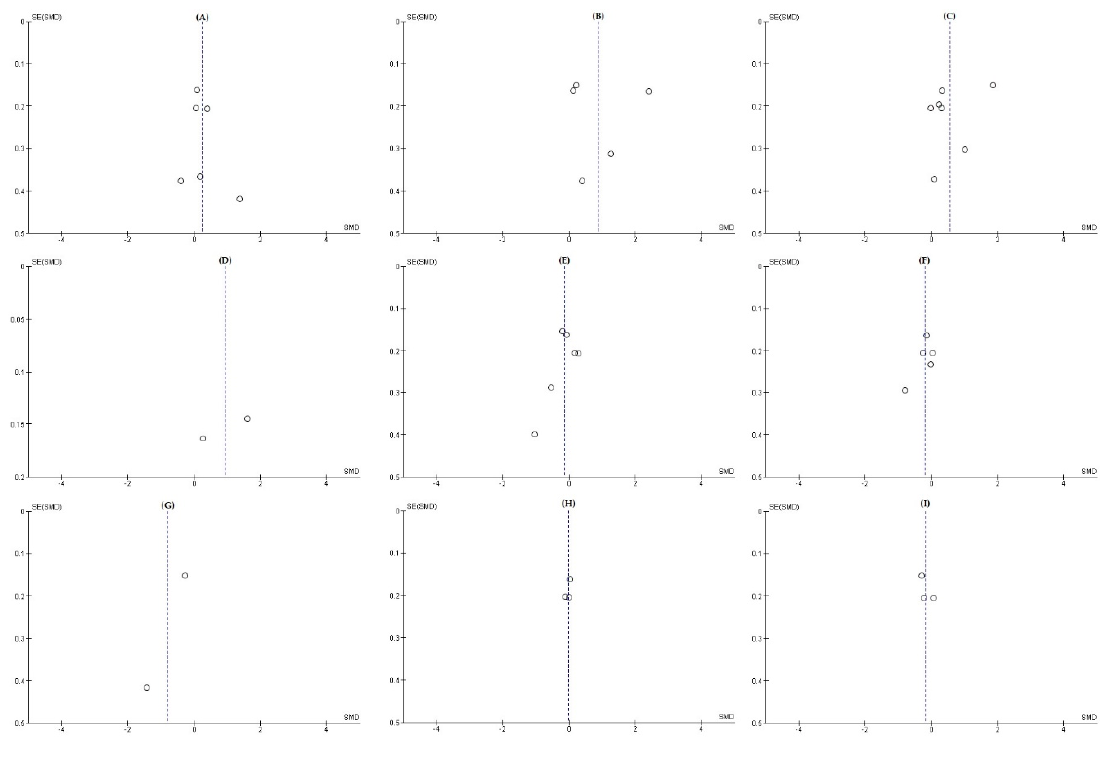
Figure 4. Funnel plots in the meta-analyses of the e ff ects of exercise on nine quality of life (QoL) domains. ( A ) General. ( B ) Physical. ( C ) Psychological. ( D ) Social. ( E ) Vasomotor symptoms. ( F ) Sexual symptoms. ( G ) Urinary symptoms. ( H ) Somatic symptoms. ( I ) Total symptoms.